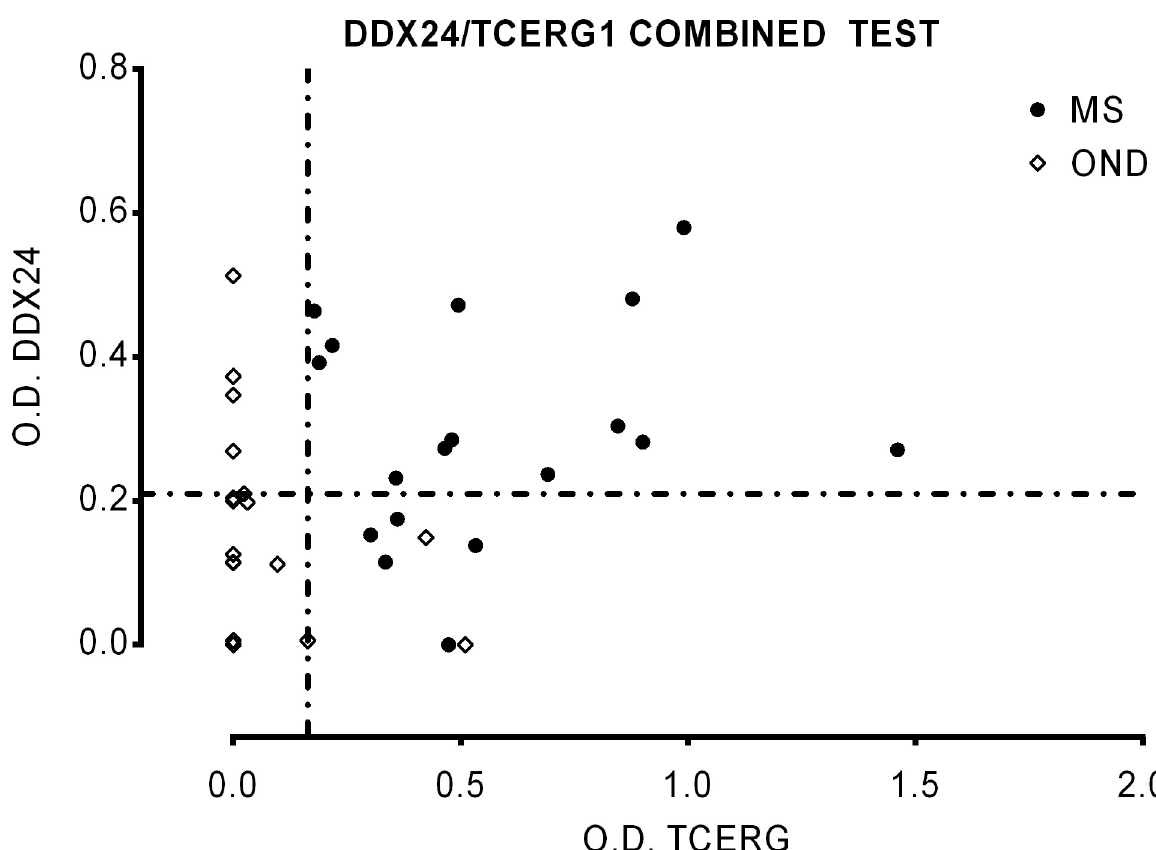
Fig 5. Evaluation of the diagnostic value of DDX24/TCERG1 combined test in the prediction of MS. Serum response against recombinant TCERG1 and DDX24 in MS (n = 18) and OND (n = 19) patients (cohort 3, Table 1) measured by ELISA (Fig 4). Individual biological replicates are shown. Dotted lines represent the cut-off with the highest Youden’s index calculated for each antigens.